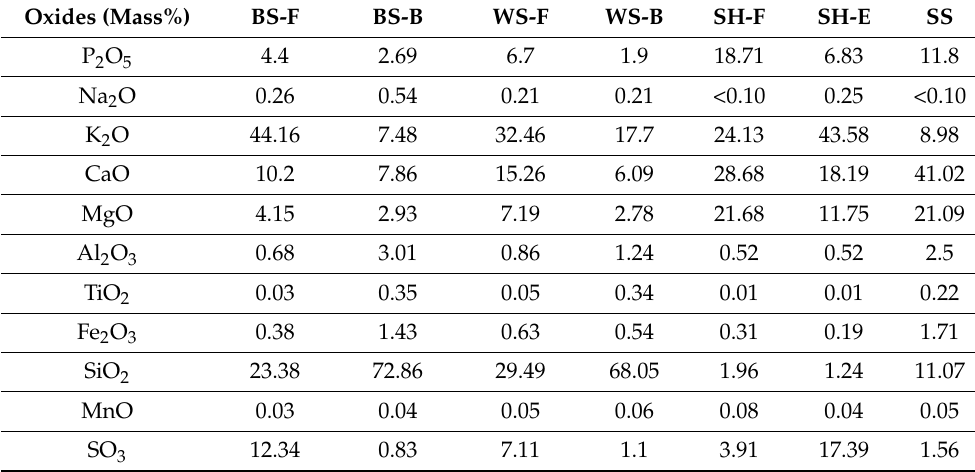
Table 2. Chemical composition of industry-generated ABAs.